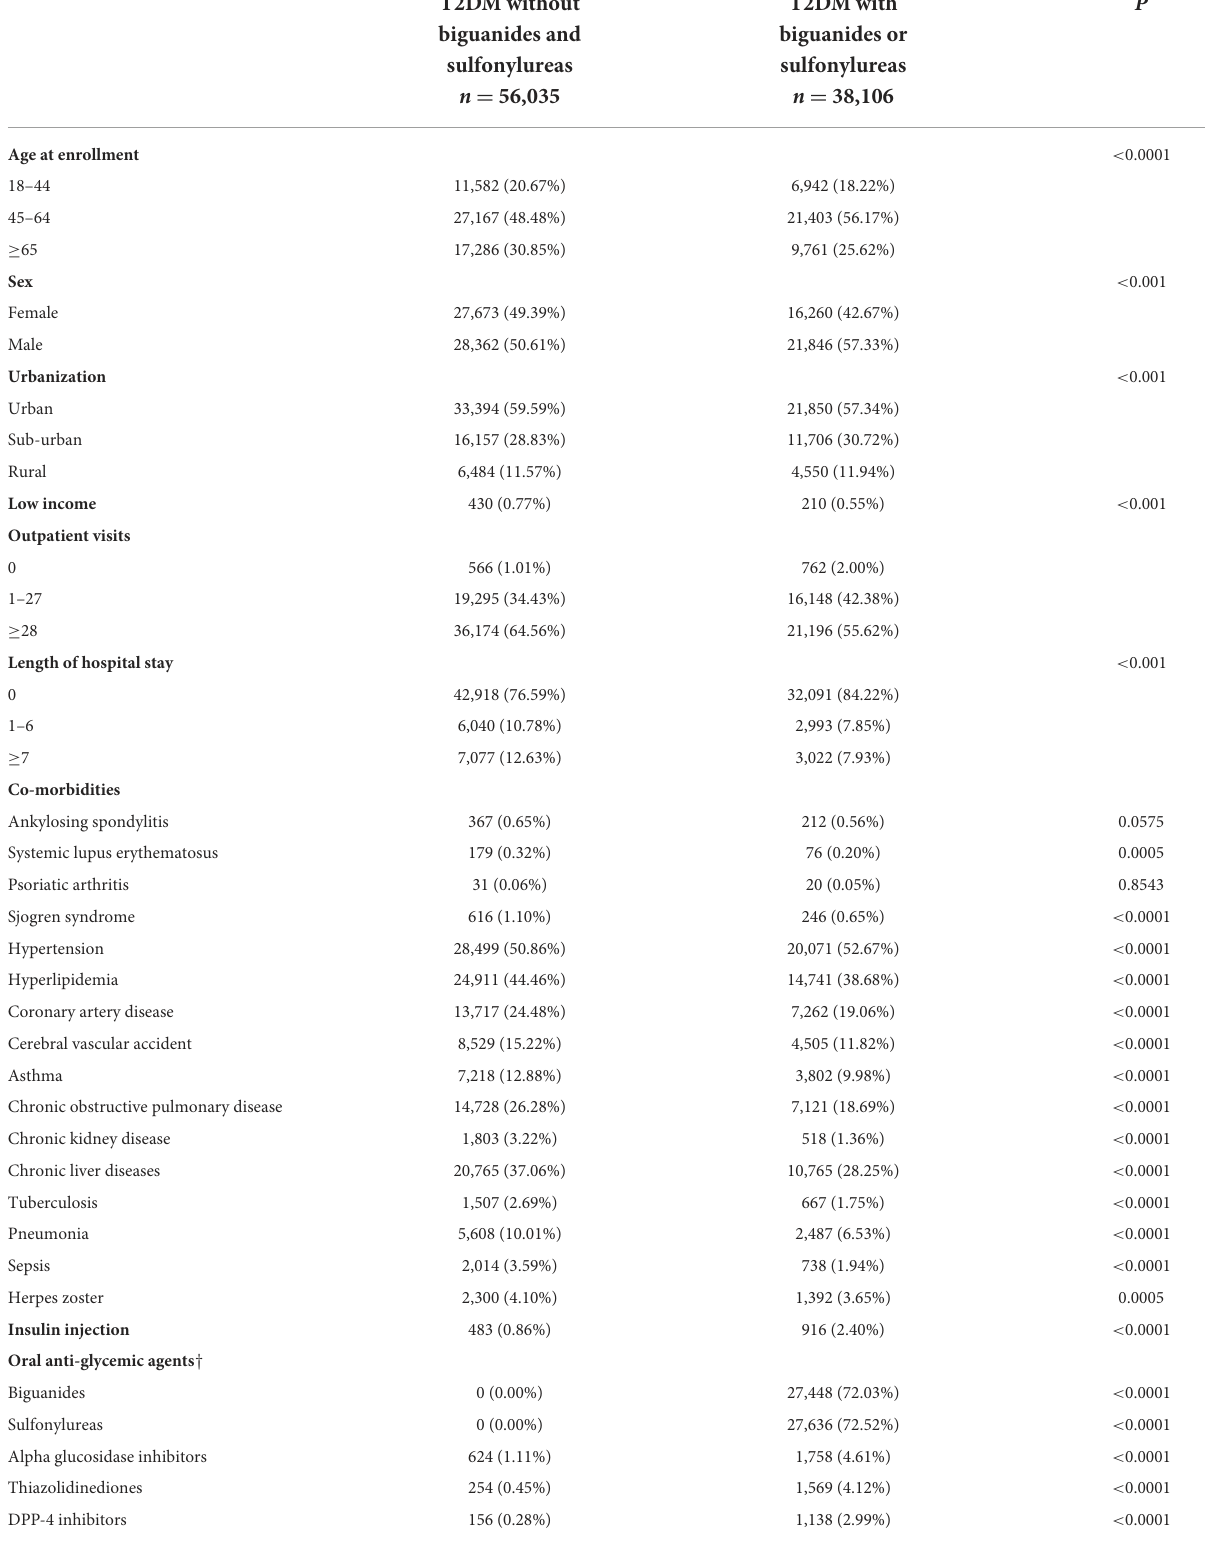
TABLE 1 Characteristics at baseline among full diabetes cohort stratified by the use of biguanides or